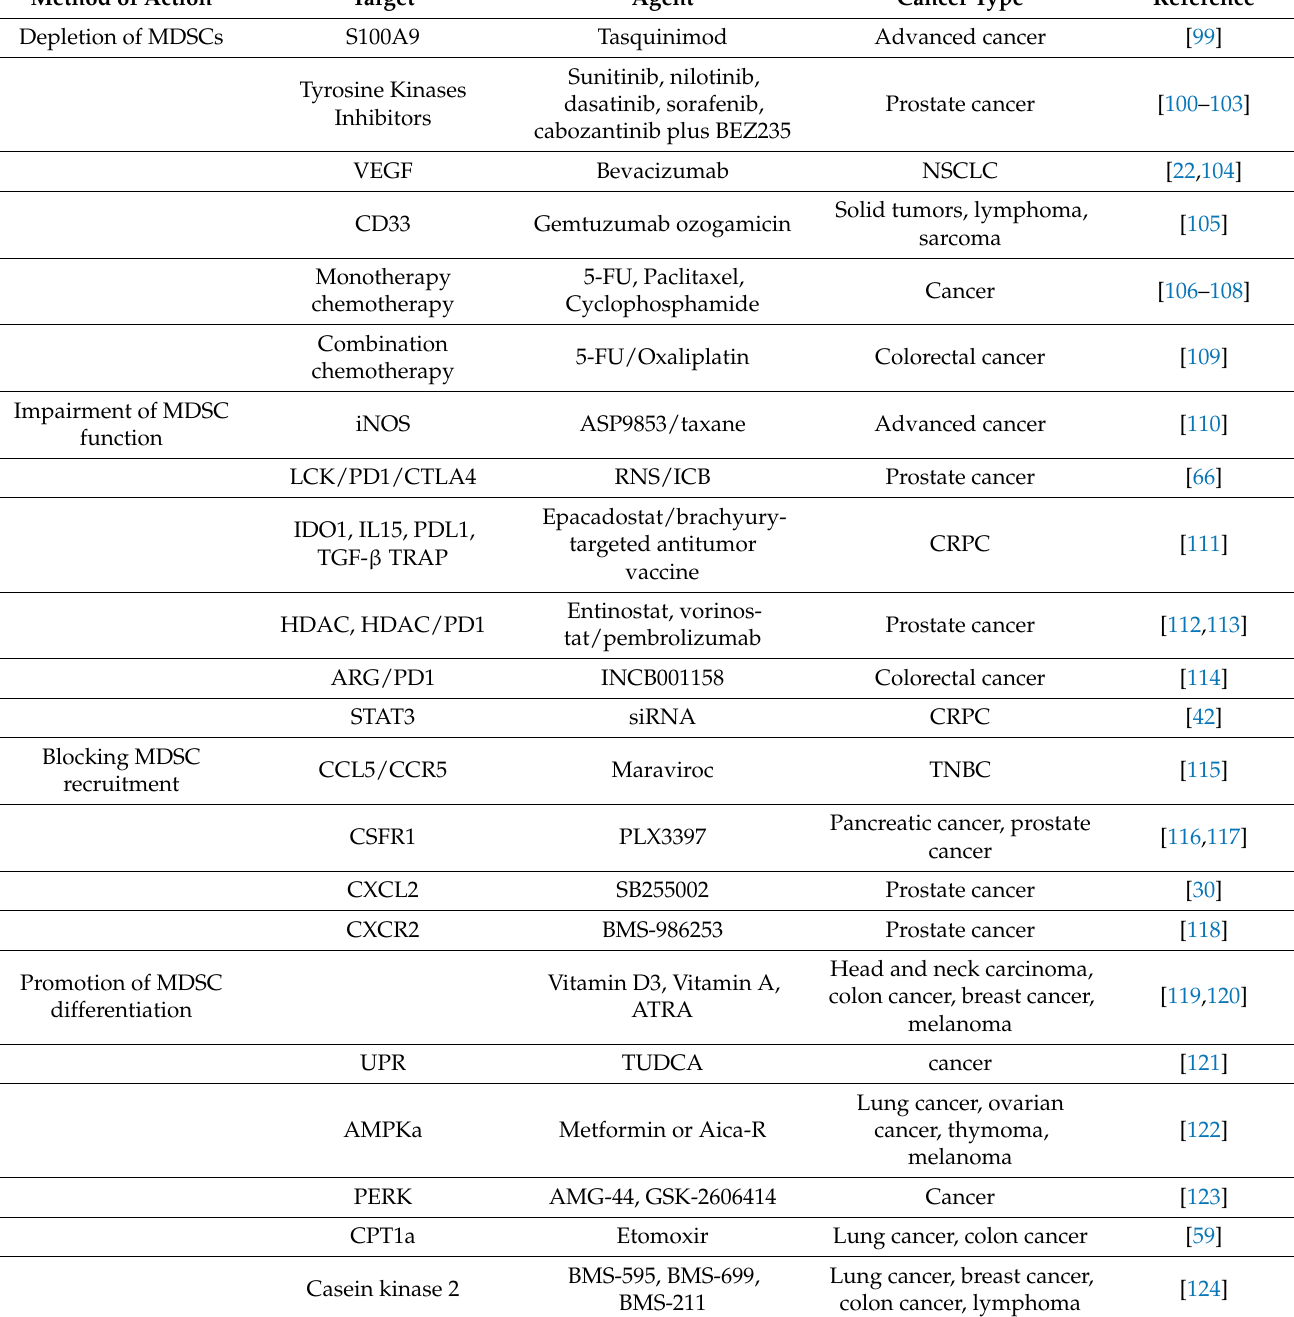
Table 1. Summary of current strategies proposed to target MDSC-mediated